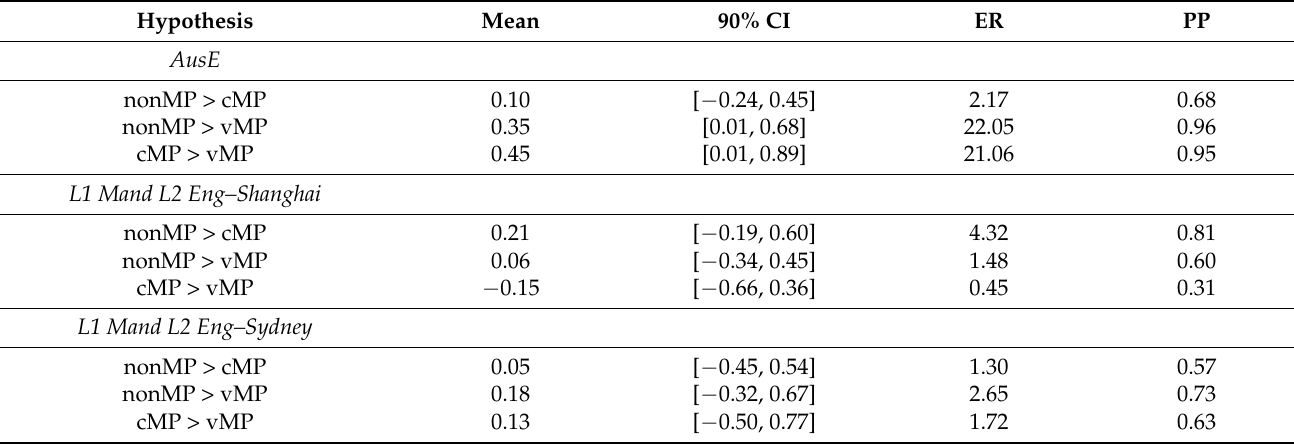
Table 1. Hypothesis test results for the evidence ratios of the accuracy models’ interaction between pair type and language group.